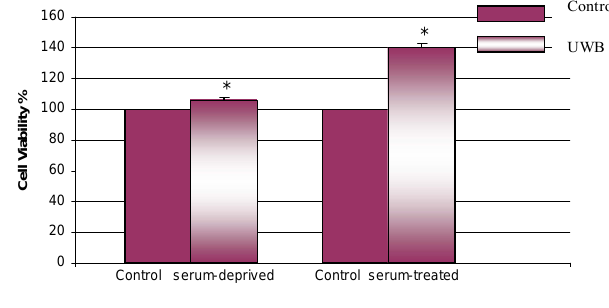
Figure 3: Effect of UWBR on HGM and SFM AML-12 mouse hepatocytes. HGM and SFM AML-12 mouse hepatocytes were exposed to UWB pulses for 2 h at a temp of 23 o C, pulse width of 10 ns, repetition rate of 1 kHz, and applied field strength of 5-20 kV/m.